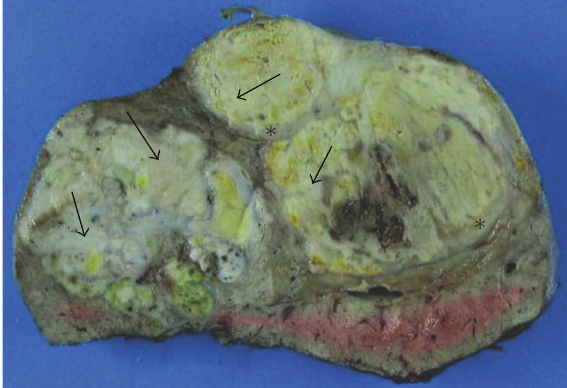
Figure 2: Macroscopic aspect of patient 1’s surgical specimen. Trans- verse section of the liver after fixation in 4% formaldehyde. The tumour has several nodules, with a focal capsule ( ∗ ), and white areas corresponding to necrosis (arrows).